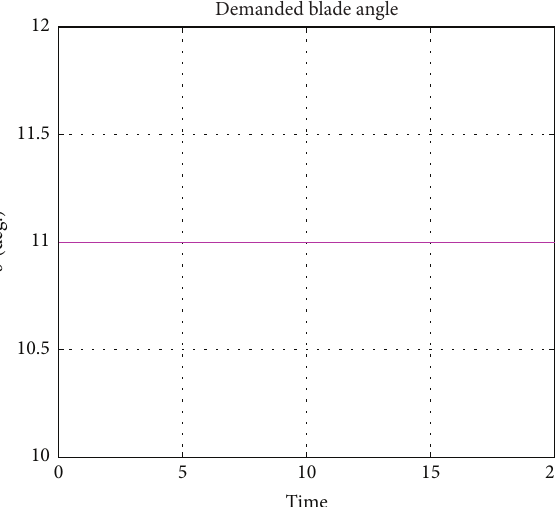
Figure 12: Demanded blade angle in degrees corresponding to Figure